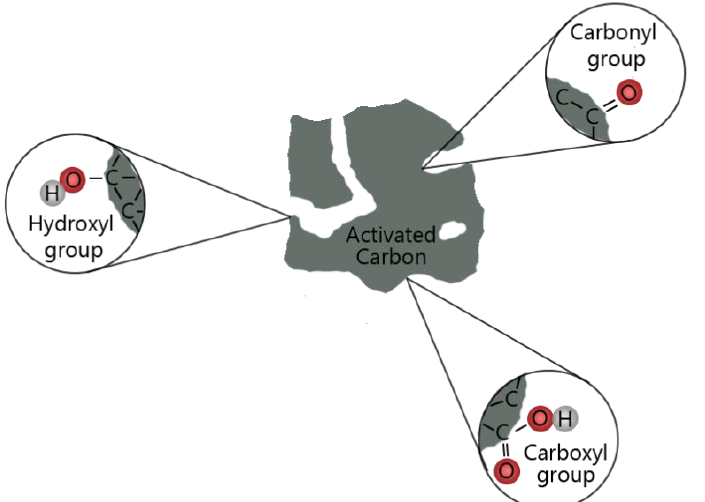
Figure 6. An illustration of hydroxyl, carbonyl and carboxyl groups on the surface of a carbonaceous solid.